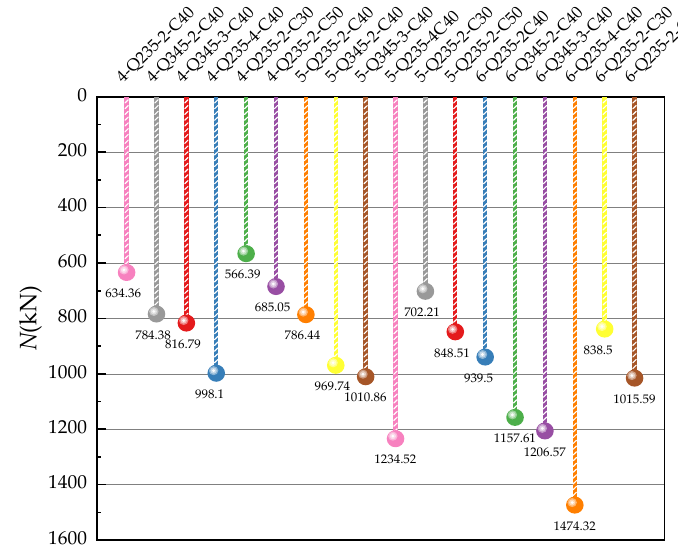
Figure 13. Axial load capacity under different parameters.